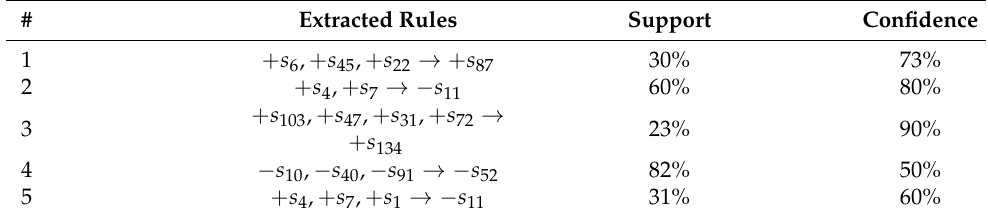
Table 2. Example of extracted association